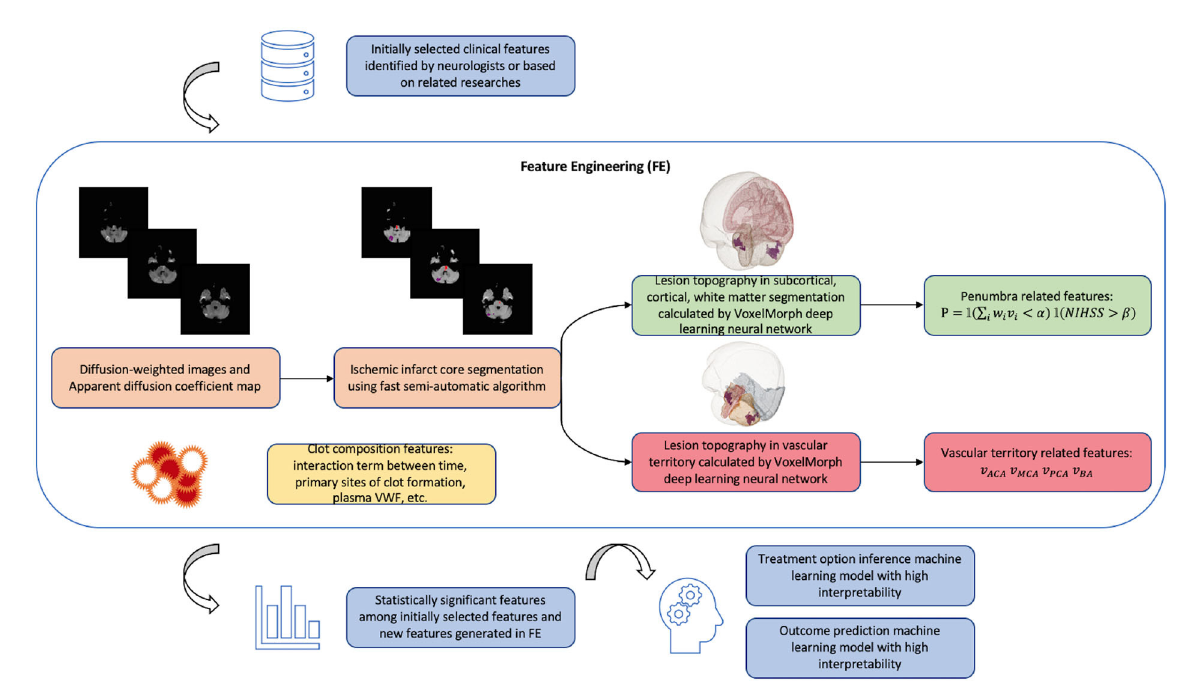
FIGURE4 Schema of new model algorithm based on the improvements that we proposed summarized in Table 1. The fast pipeline to calculate advanced radiological features in FE was published in our previous research (68). Penumbra related features are calculated based on